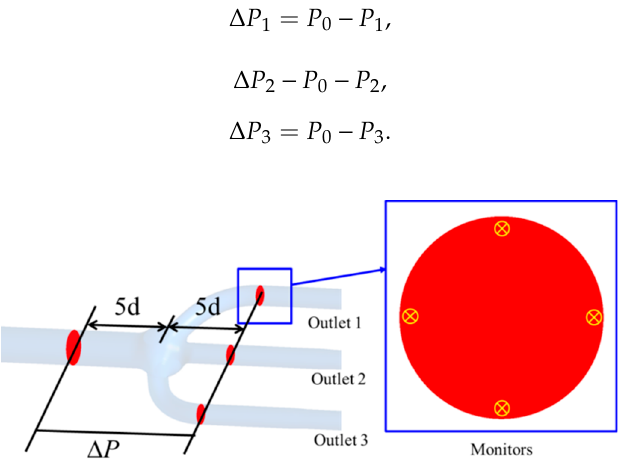
Figure 5. Definitions of total pressure differences.